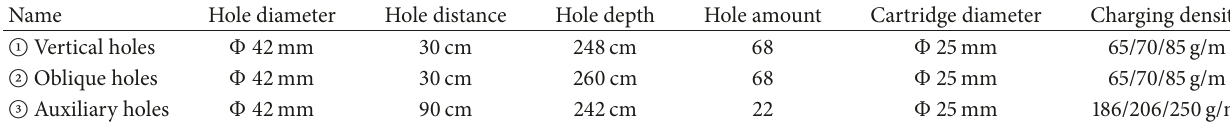
Table 1: Different blast hole layout and charge parameter.